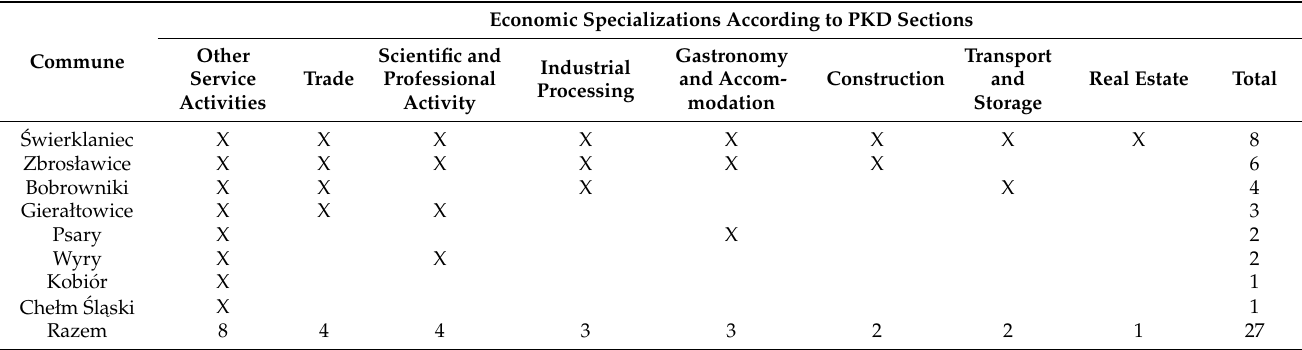
Table 4. Economic specializations in rural areas in the hinterland of the GZM.